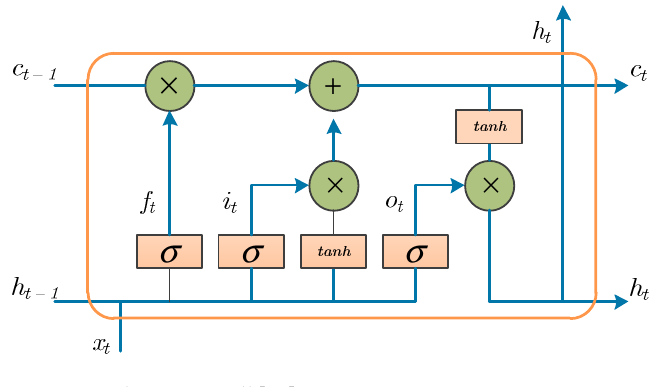
Figure A1. The LSTM cell [73].